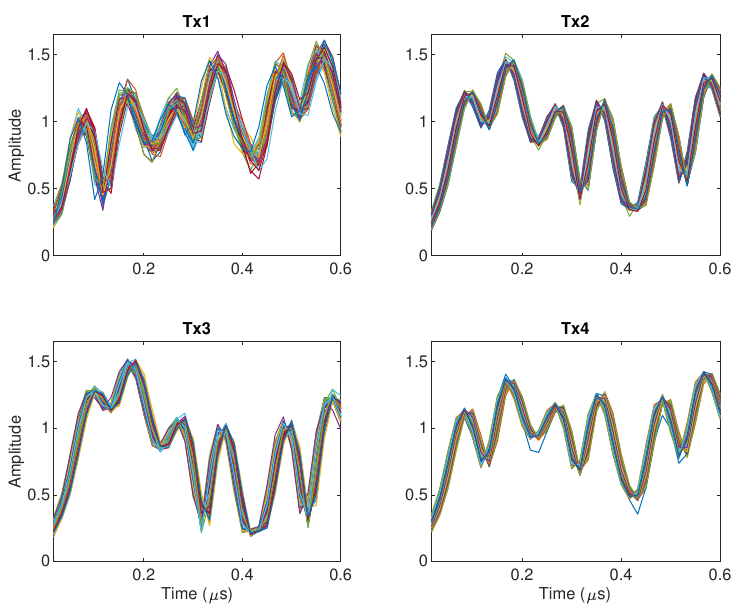
Figure 12. Instantaneous amplitude characteristics obtained from four different Wi-Fi transmitters.